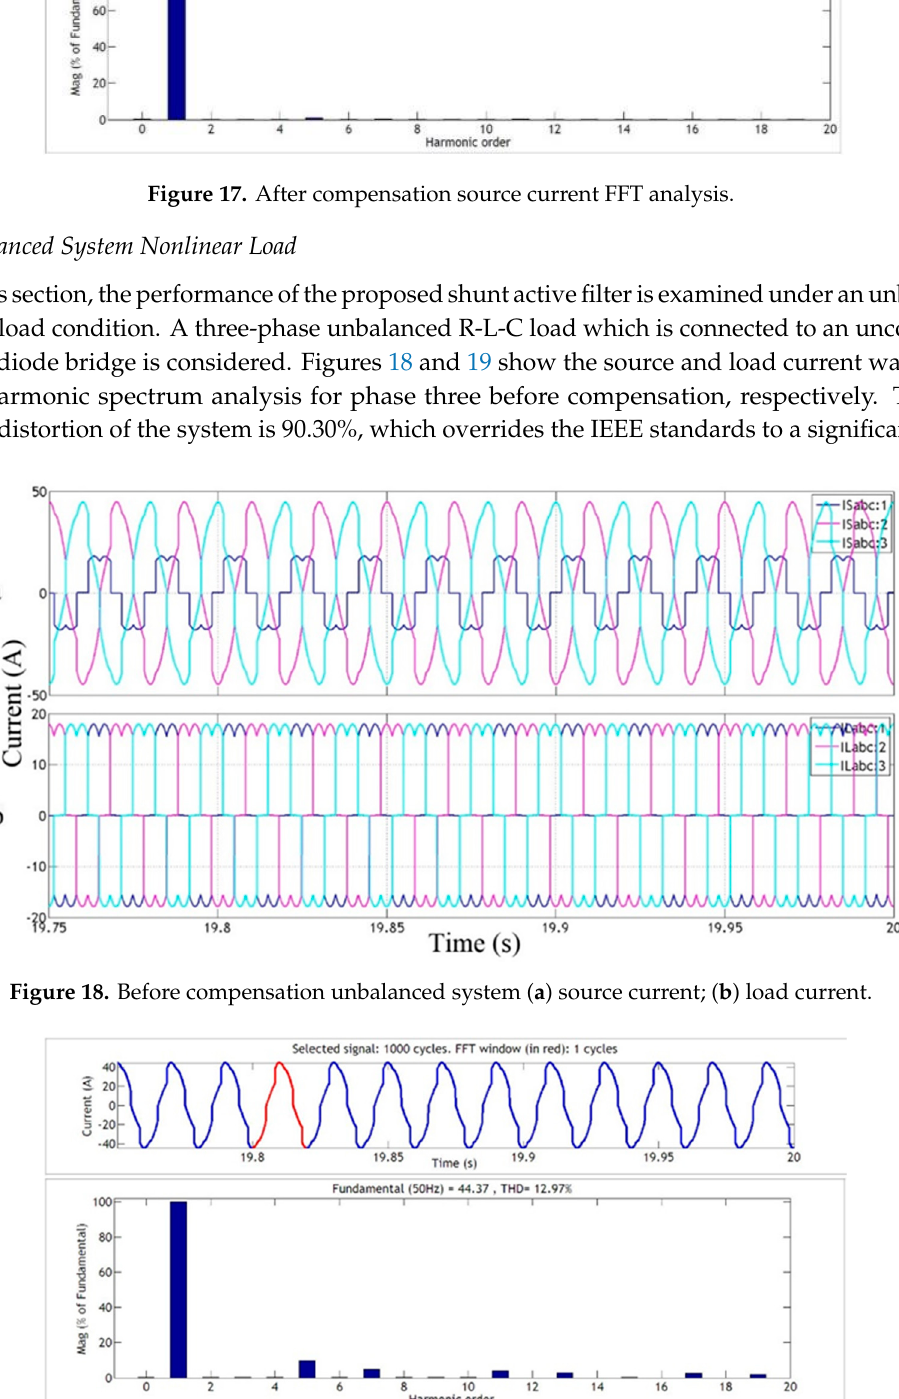
Figure 17. After compensation source current FFT analysis.